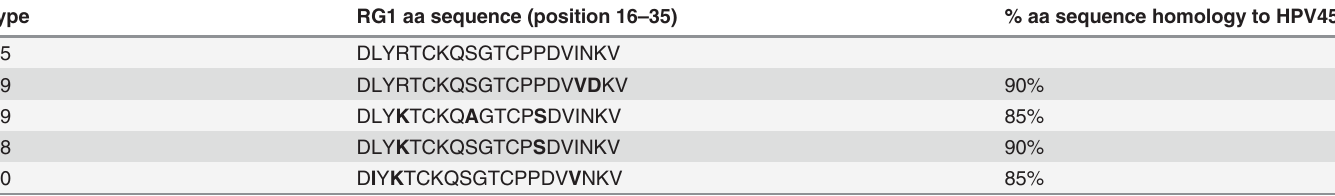
Table 3. RG1 amino acid sequence